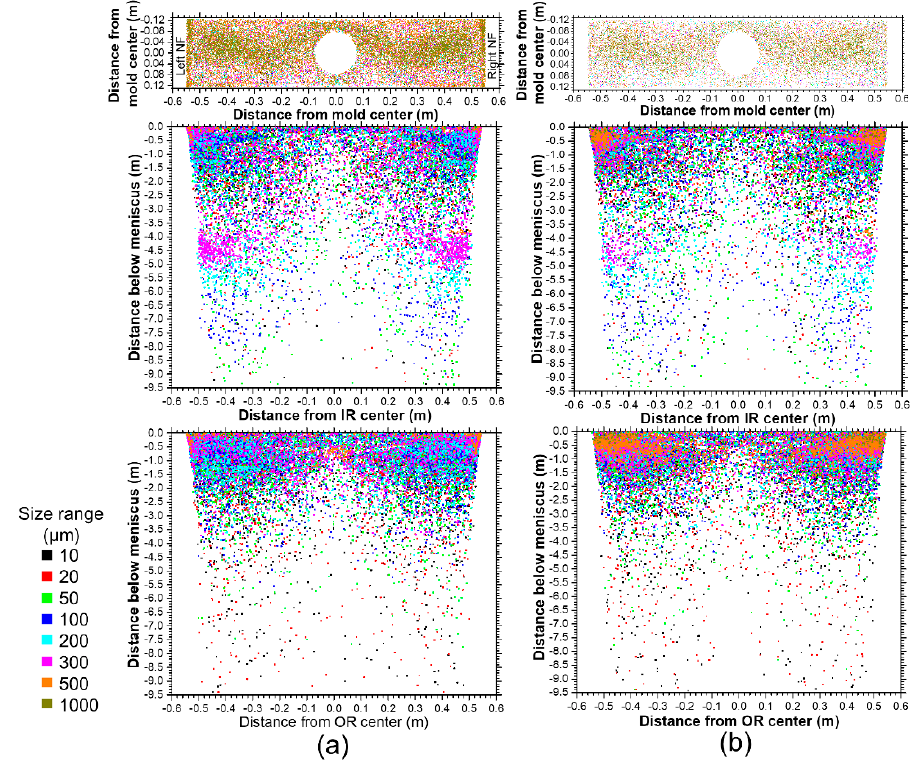
Figure 11. Inclusion capture locations on top surface slag layer (top view, upper frame), IR steel shell (front view middle frame), and OR steel shell (front view lower frame), comparing ( a ) advanced capture criterion and ( b ) simple capture criterion predictions.